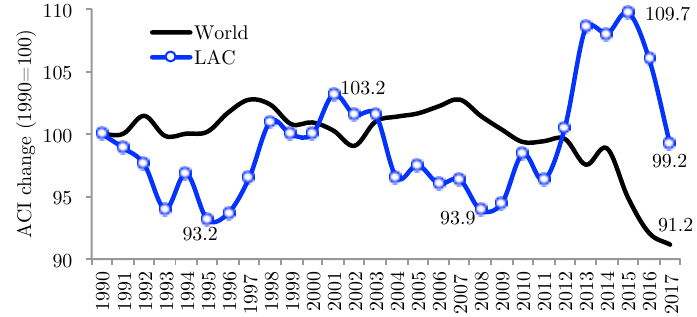
Figure 1. Change of power sector’s aggregate carbon intensity in Latin America and the Caribbean (LAC) and the World, period 1990–2017, (1990 = 100)